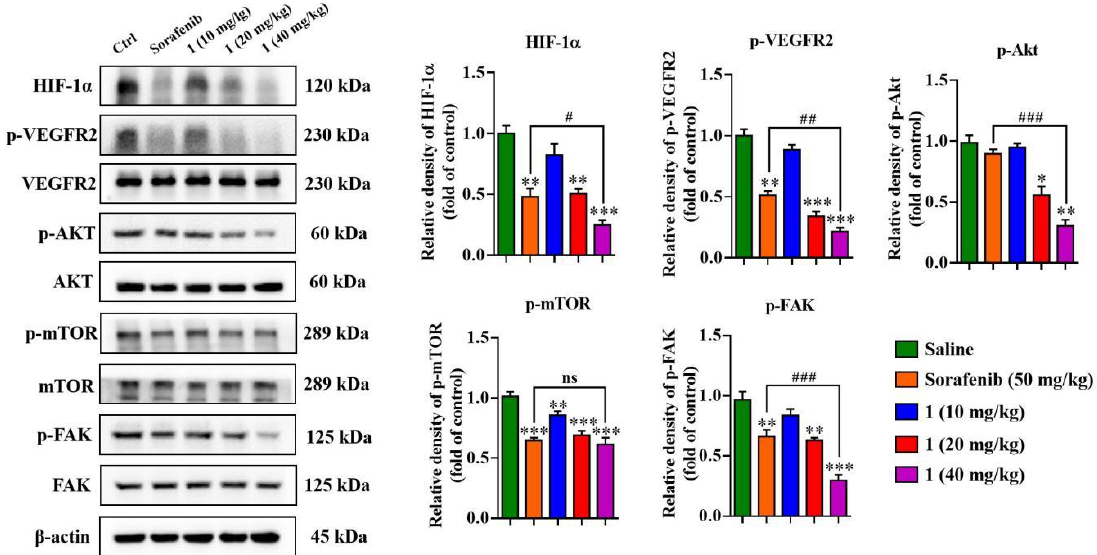
Figure 10. The effects of 1 on protein expression and phosphorylation levels of HIF-1 α , VEGFR2 and its downstream signaling pathways of tumor tissue in 4T1 mammary carcinoma model. The levels of HIF-1 α , p-VEGFR2, VEGFR2, p-Akt, Akt, p-mTOR, mTOR, p-FAK and FAK were determined by Western blots. ( n = 3, means ± SEM are shown, * p < 0.05, ** p < 0.01, *** p < 0.001, compared with Saline treatment group; # p < 0.05, ## p < 0.01, ### p < 0.001, compared with Sorafenib treatment group).